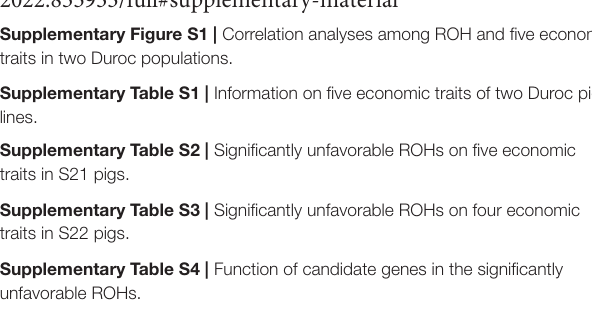
Supplementary Figure S1 | Correlation analyses among ROH and five economic traits in two Duroc populations. Supplementary Table S1 | Information on five economic traits of two Duroc pig lines. Supplementary Table S2 | Significantly unfavorable ROHs on five economic traits in S21 pigs. Supplementary Table S3 | Significantly unfavorable ROHs on four economic traits in S22 pigs. Supplementary Table S4 | Function of candidate genes in the significantly unfavorable